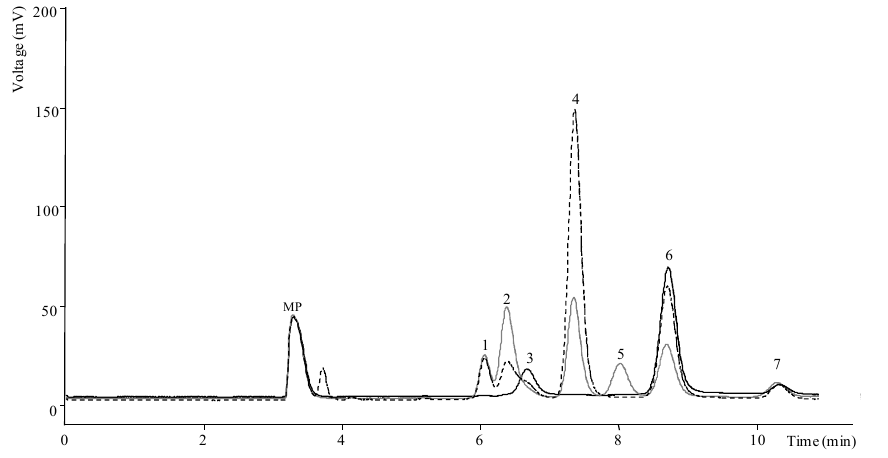
Figure 2. Chromatogram of sugars in cherry, plum and natural yogurts, obtained by HPLC-RI: 1—fructose; 2—glucose; 3—galactose; 4—sucrose; 5—maltose; 6—lactose; 7—raffinose (IS); MP: mobile